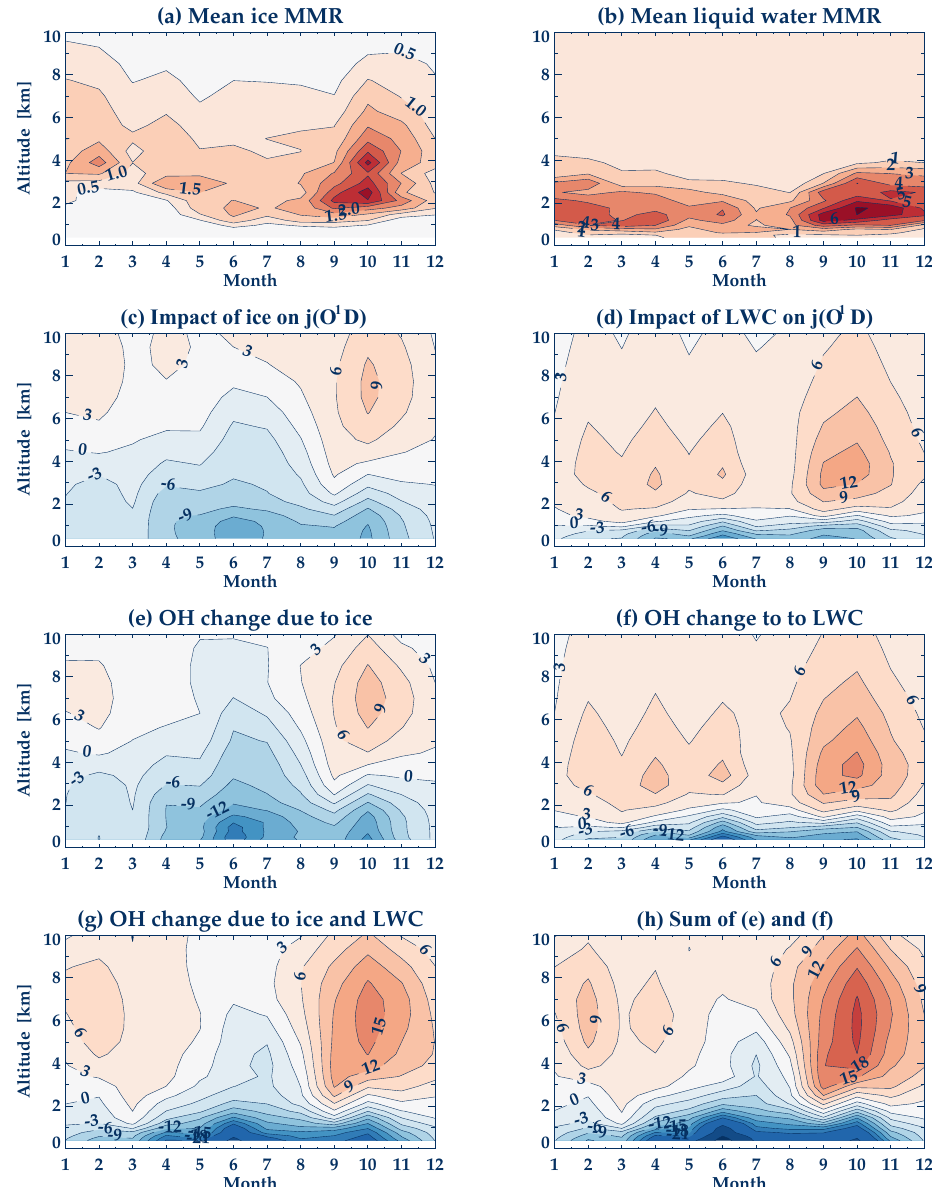
Figure 12. Multi-annual and monthly-mean OH responses to the presence of clouds. Multi-annual and monthly mean (a) ice content (10 − 5 kgkg − 1 ). (b) liquid water content (10 − 5 kgkg − 1 ). (c) Response of j (%) to the presence of ICs relative to the cloud-free ref- O 1 D erence simulation. (d) response of j (%) to the presence of LWCs relative to the cloud-free reference simulation. (e) response of OH O 1 D (%) to the presence of ICs relative to the cloud-free reference simulation. (f) Response of OH (%) to the presence of LWCs relative to the cloud-free reference simulation. (g) response of OH (%) to the presence of both LWCs and ICs relative to the cloud-free reference simulation. (h) Sum of (e) and (f)